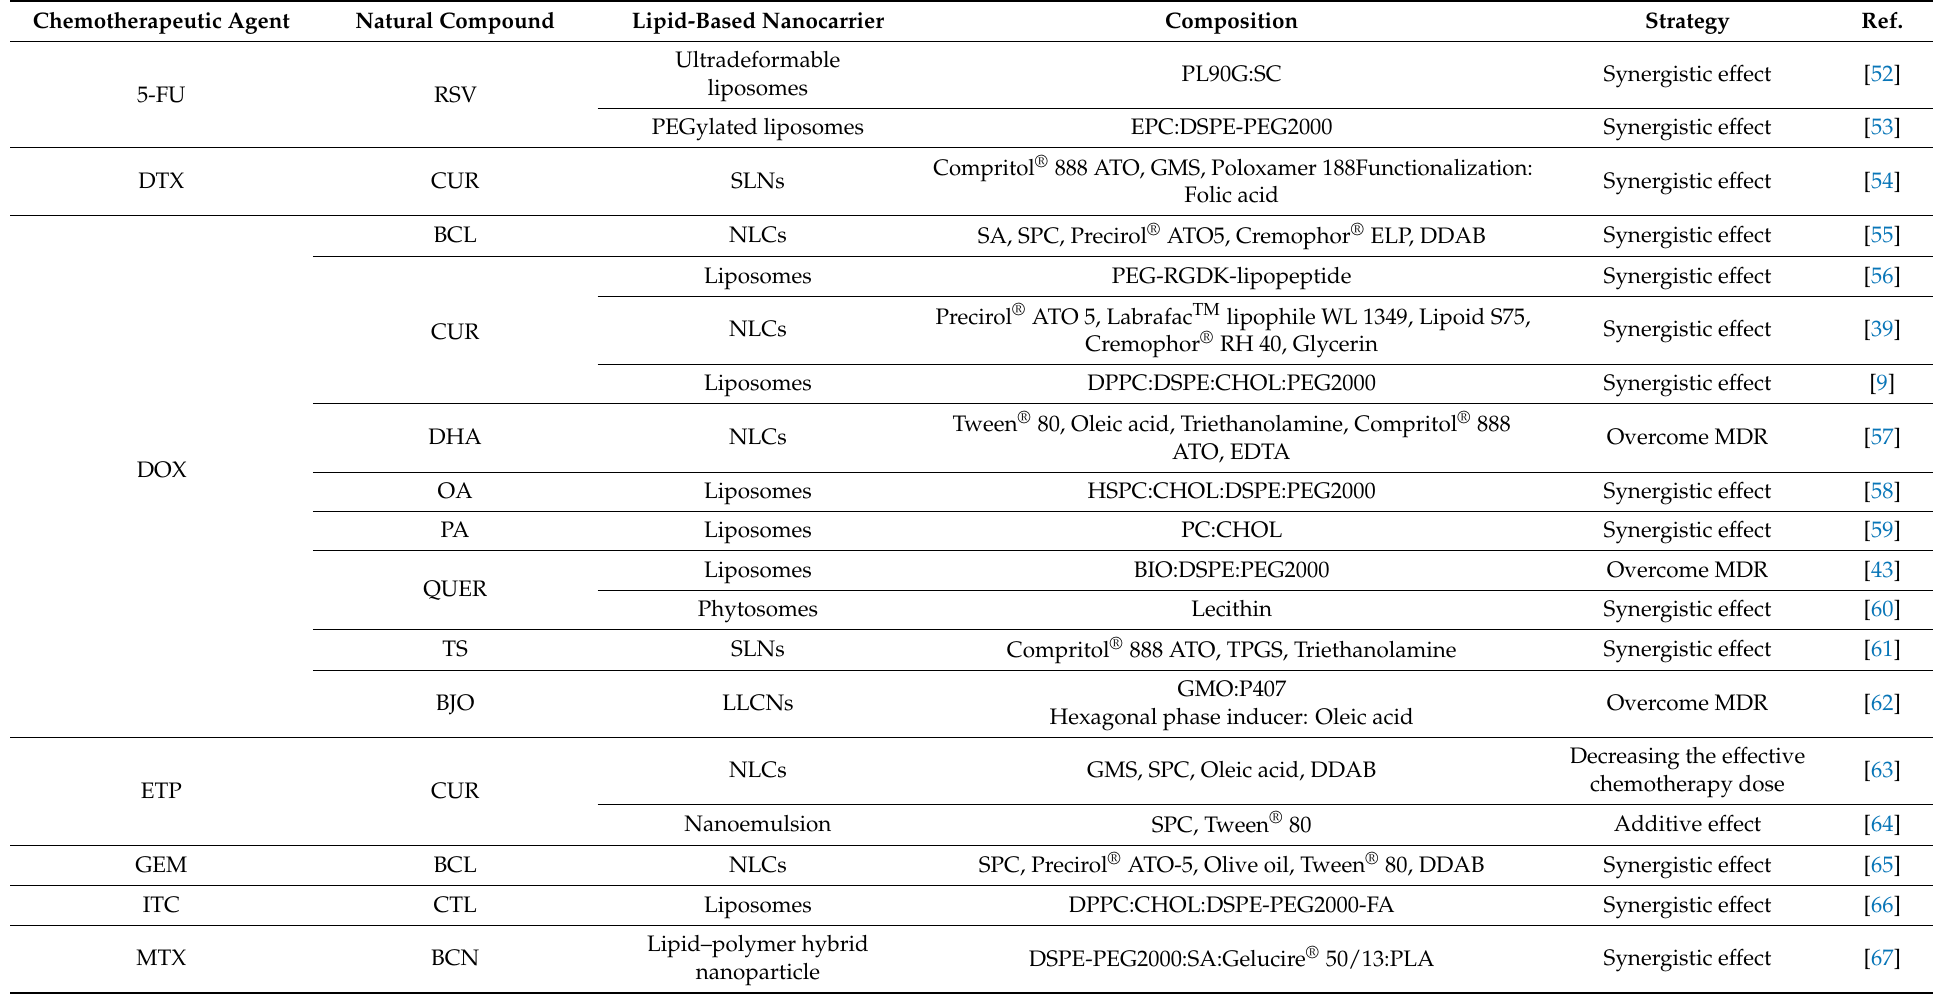
Table 1. Examples of lipid-based nanocarriers co-encapsulating a chemotherapeutic agent and a natural compound for cancer